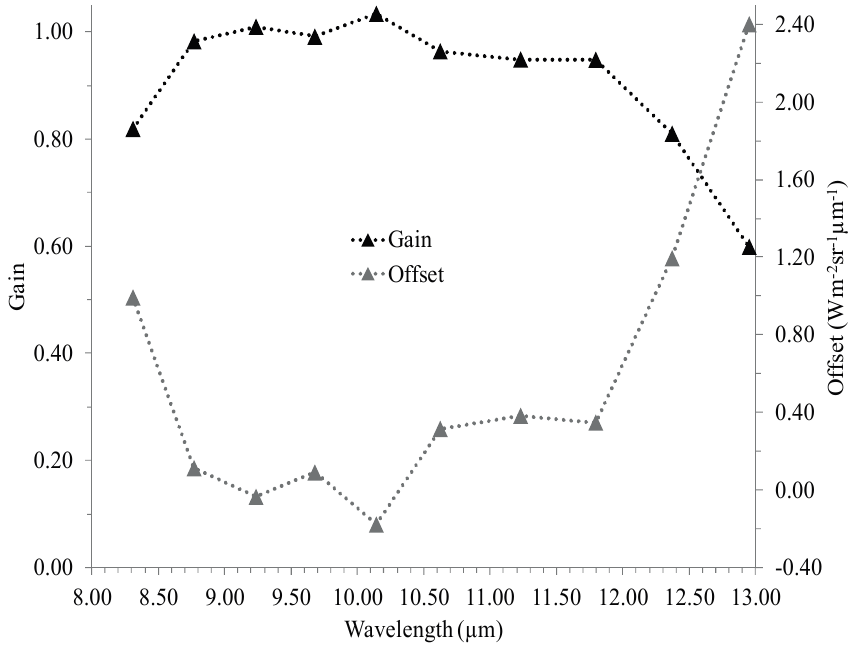
Figure 4. The gain (primary y-axis) and offset (secondary y-axis) spectra, as calculated from the water and conifer